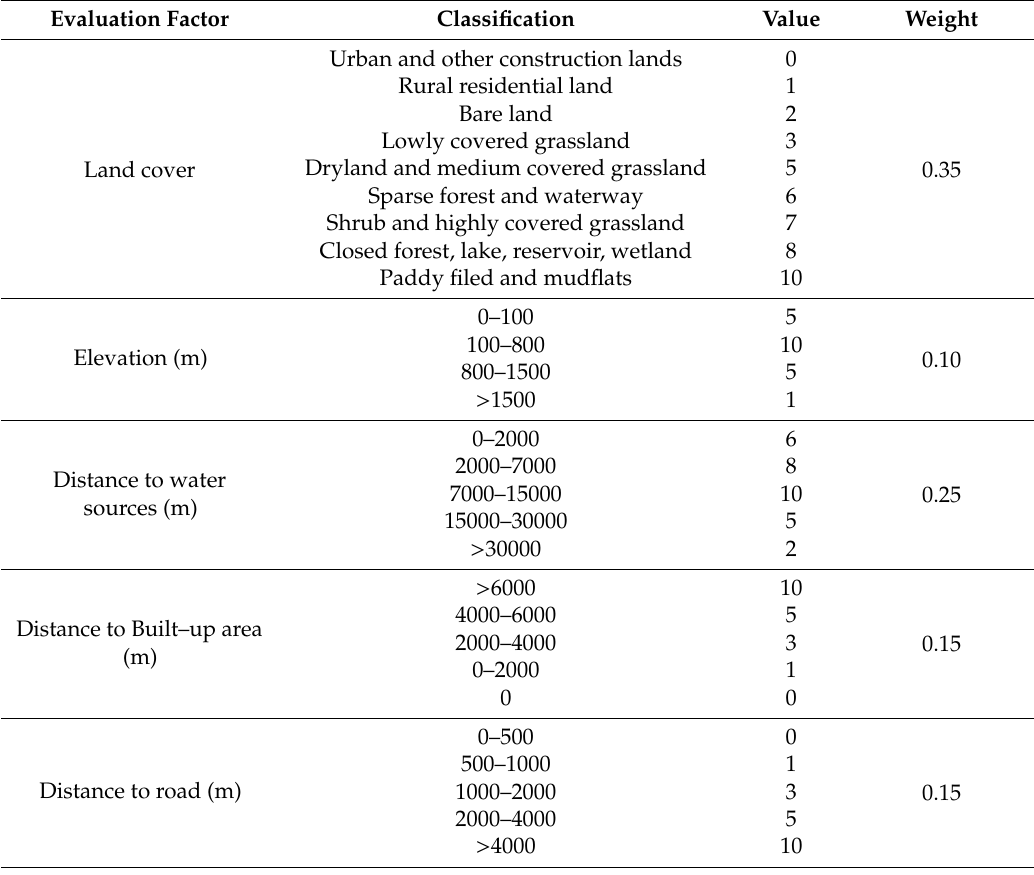
Table 7. Criteria for biological habitat suitability.